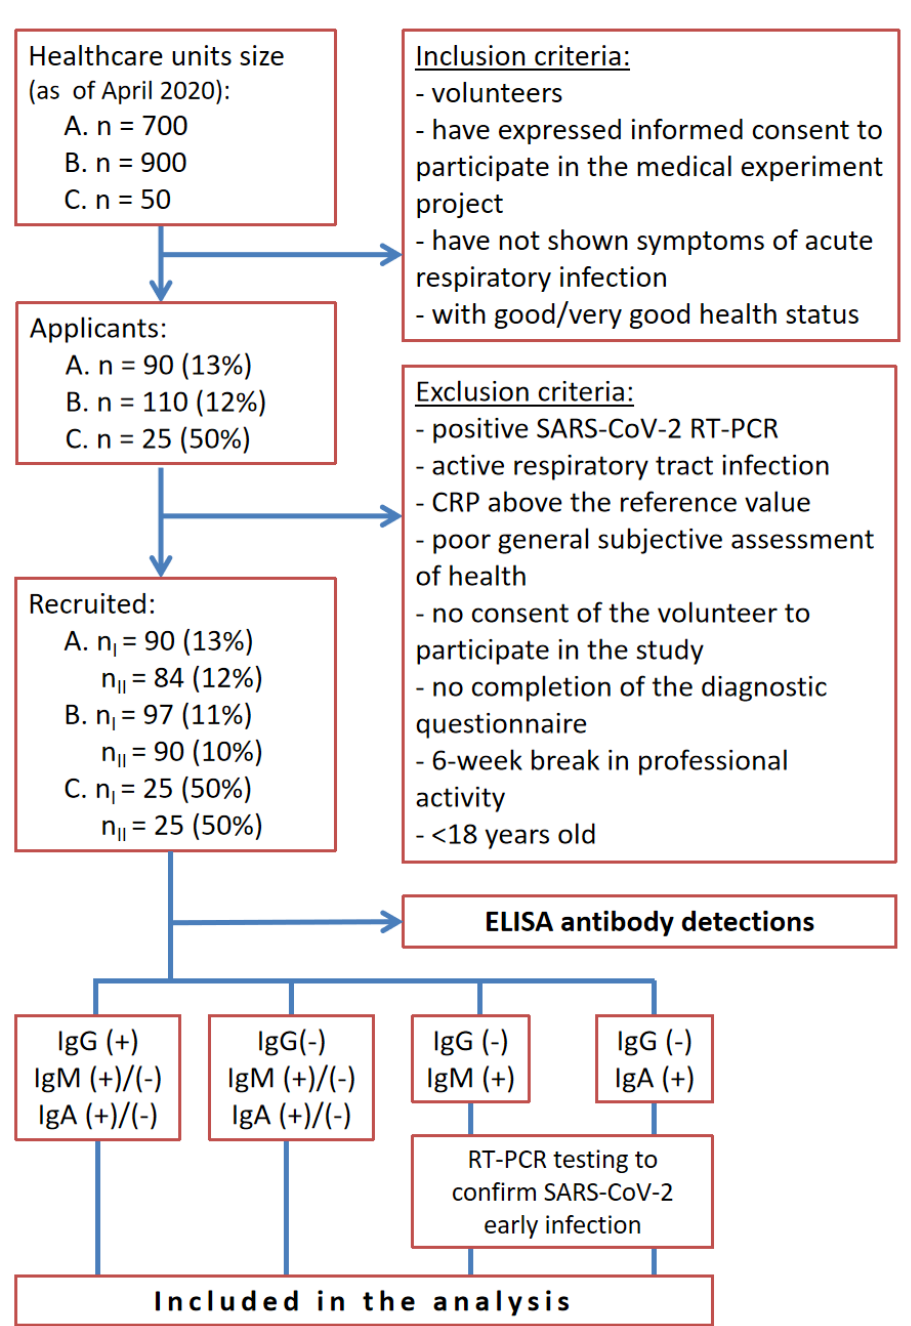
Figure 1. Study design flowchart in three Polish medical institutions (A.-University Hospital in Opole; B.-Hospital no. 4 in Bytom and C.-Eko-Prof-Med Healthcare Unit (HCU) in Miasteczko ´Sl ˛askie; HCWs-health care workers; n I -first blood collection; n II -second blood collection; RT-PCR-Reverse Transcription Polymerase Chain Reaction), CRP-C-reactive